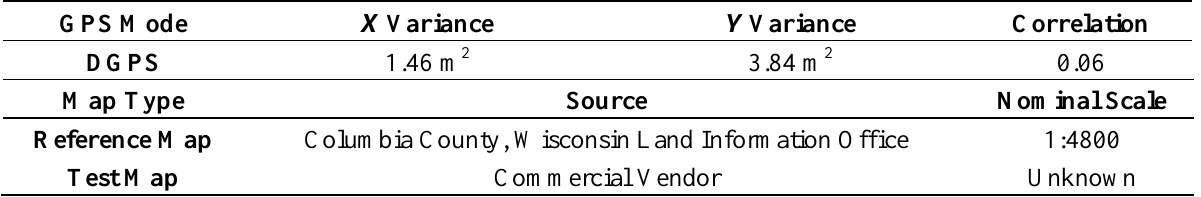
Table 1. Uncertainty properties in DGPS